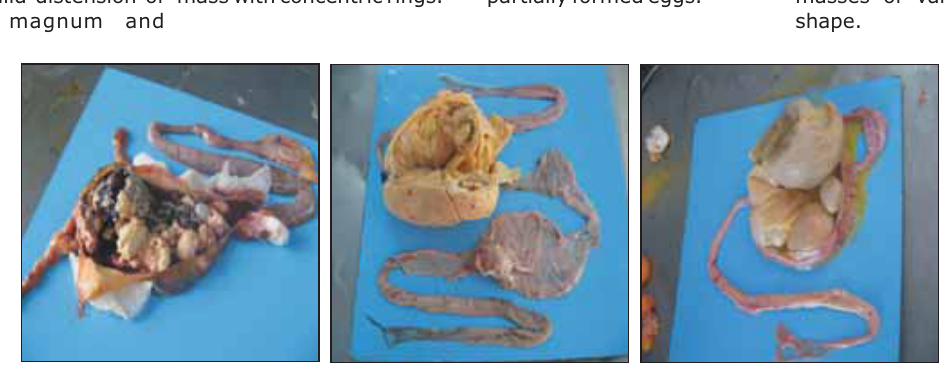
Figure-6: Oviduct impaction: Impacted yolk and albuminous mass with concentric rings.